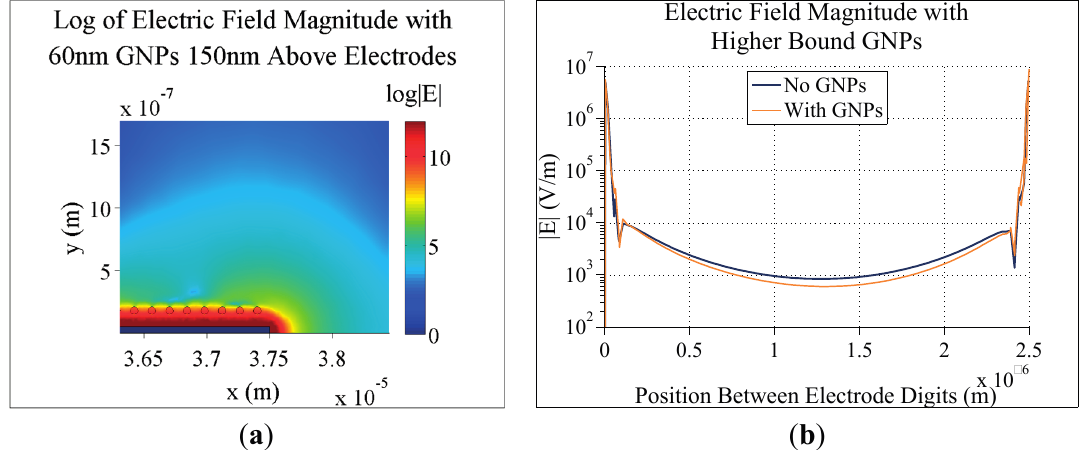
Figure 11. ( a ) Simulation of the electric field magnitude of 5 µm digit and 2.5 µm gap electrodes with 0.1 V applied, 10 mM KCl concentration and 60 nm GNPs bound 150 nm above the electrodes; ( b ) A graph of the electric field magnitude directly between the gaps in these electrodes with and without gold nanoparticles.